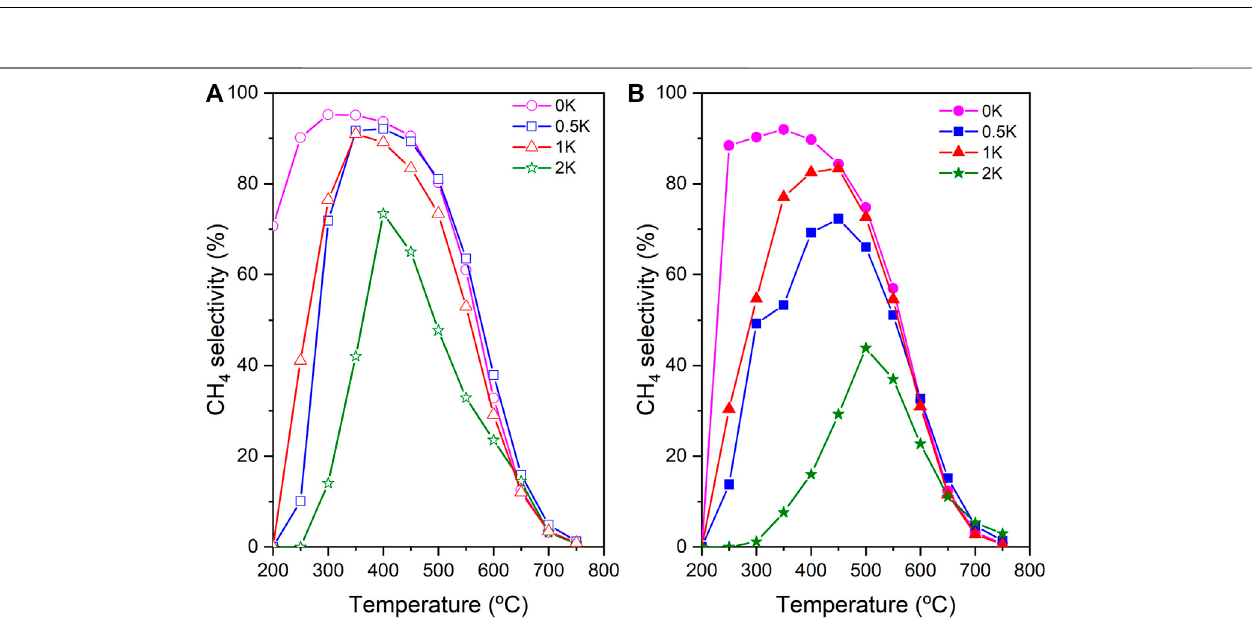
FIGURE 8 | CH 4 selectivity of (A) non-reduced catalysts and (B) reduced catalysts.